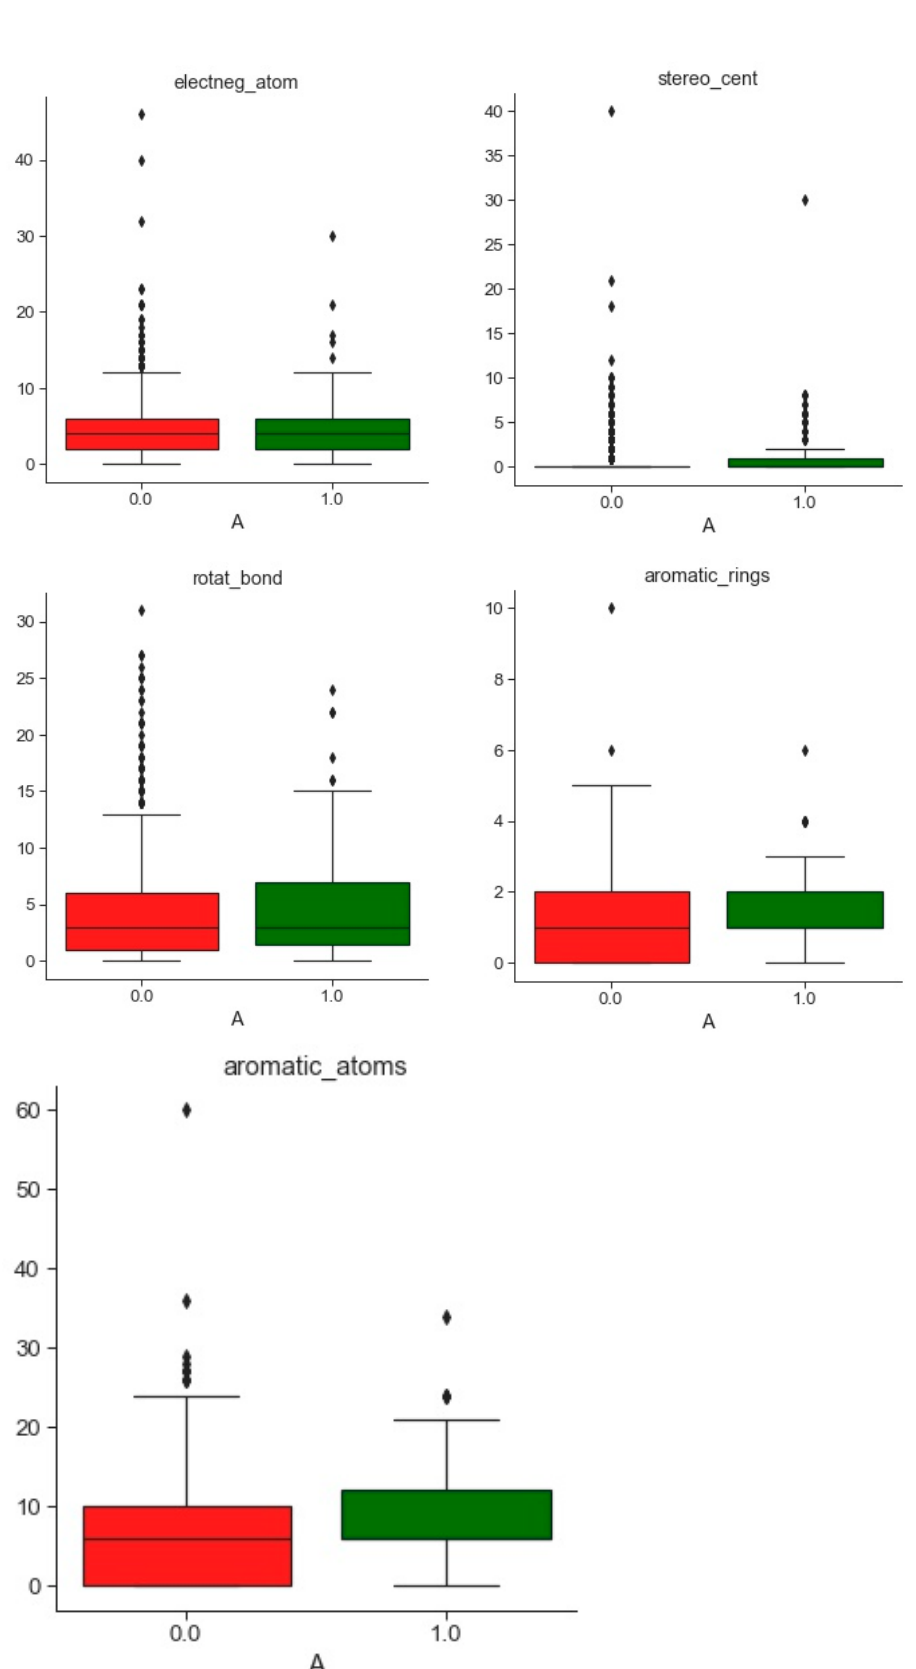
Figure 1. Boxplots representing the distribution of physiochemical descriptors computed with Datawarrior [26] for binding compounds (B) in green and non-binding (NB) compounds in red. Two external validation sets were used, i.e., the NR-DBIND (Nuclear Receptors Da- taBase Including Negative Data) ER α set that comprises 732 compounds, divided into 554 B compounds and 178 NB compounds, and the EADB (Estrogenic Activity DataBase) set comprising 131 B compounds and 101 NB compounds for a total of 232 molecules. Distri- butions of the 15 constitutional, physiochemical, and molecular descriptors for each da- taset are presented in Supplementary Figures S1 and S2. 2.1.2. Databases Comparison Pairwise similarities were calculated using the Tanimoto coefficient (Tc) between each pair of topological fingerprints for: 1.) the EPA database and the NR-DBIND and 2.) the EPA and the EADB (see Figure S3A). The analysis of similarity values shows that the Tc are globally very low with a mean of 0.181 for the pairing with NR-DBIND and 0.174 for the pairing with EADB. Only 2% and 0.6% of the total calculated Tc for EADB and NR- DBIND, respectively (as shown in Figure S3B), are higher than 0.5. Finally, the chemical space of the three databases was mapped using a SALI (Structure Activity Landscape In- dex) map for the whole databases (Figure 2). The map illustrates that all three databases share the same chemical space.